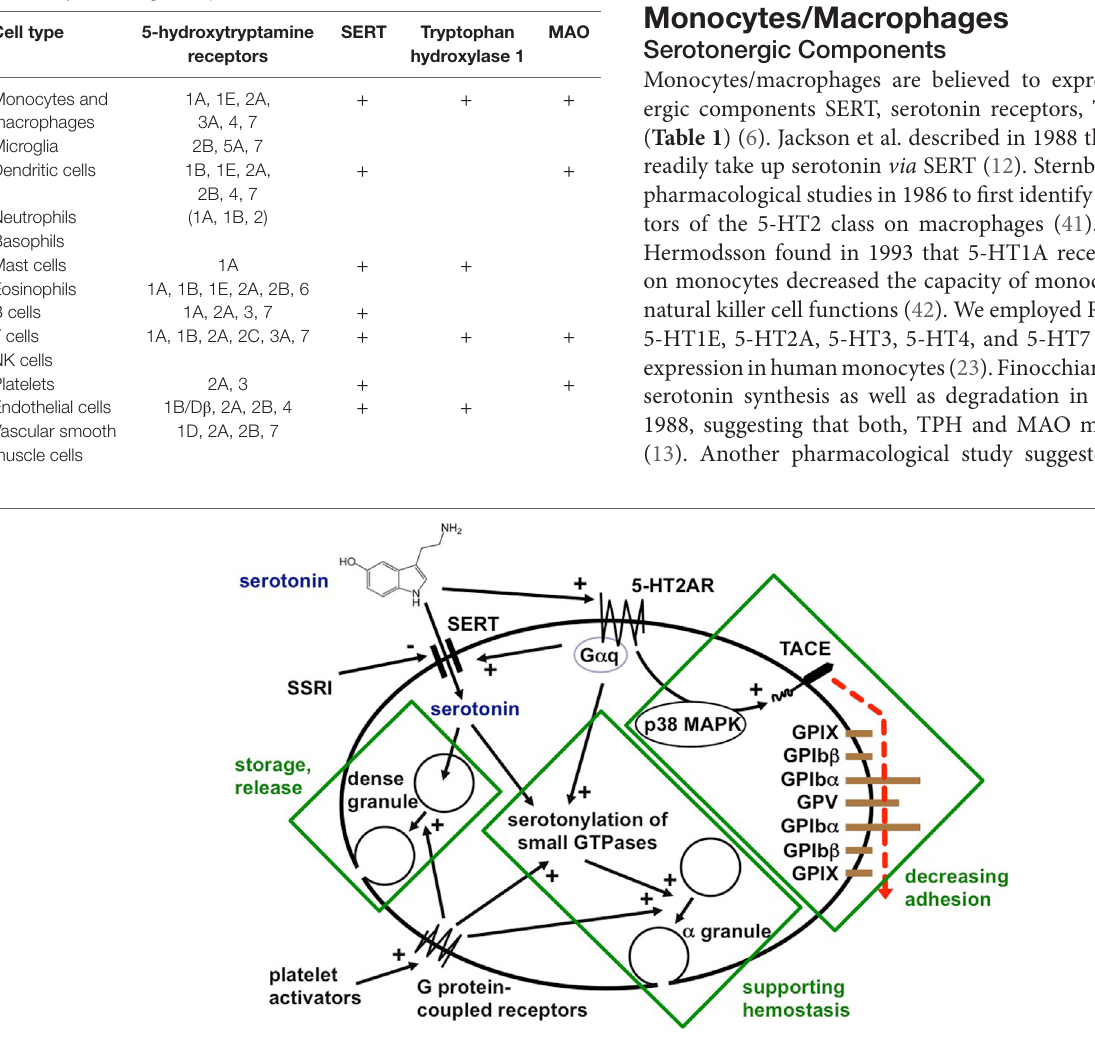
FigURe 2 | Schematic drawing of serotonin storage in dense granules, α -granule secretion, and TNF- α -converting enzyme (TACE) activation in platelets [modified from Duerschmied et al. (7)].